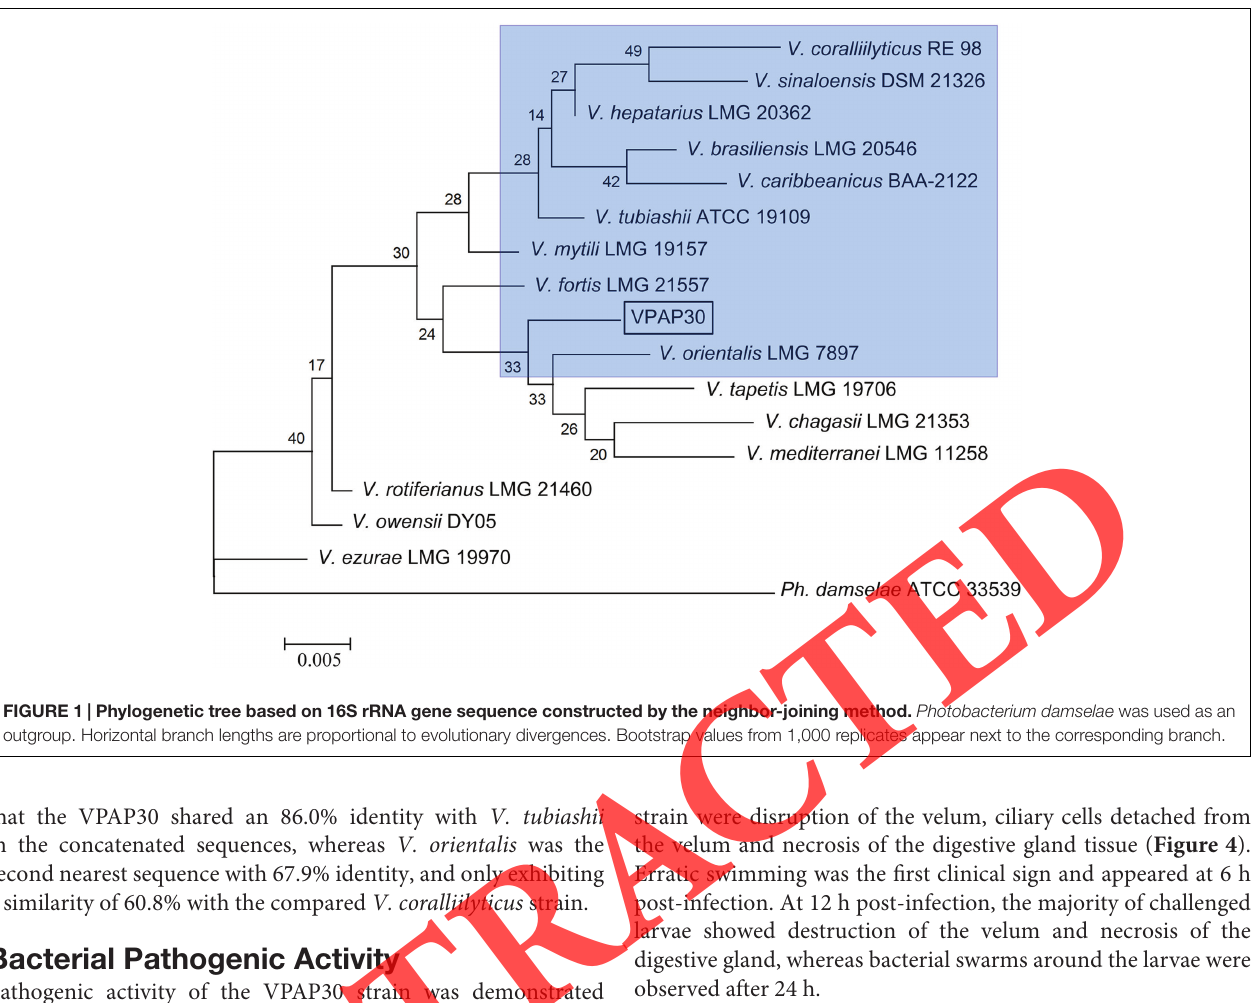
that the VPAP30 shared an 86.0% identity with V.